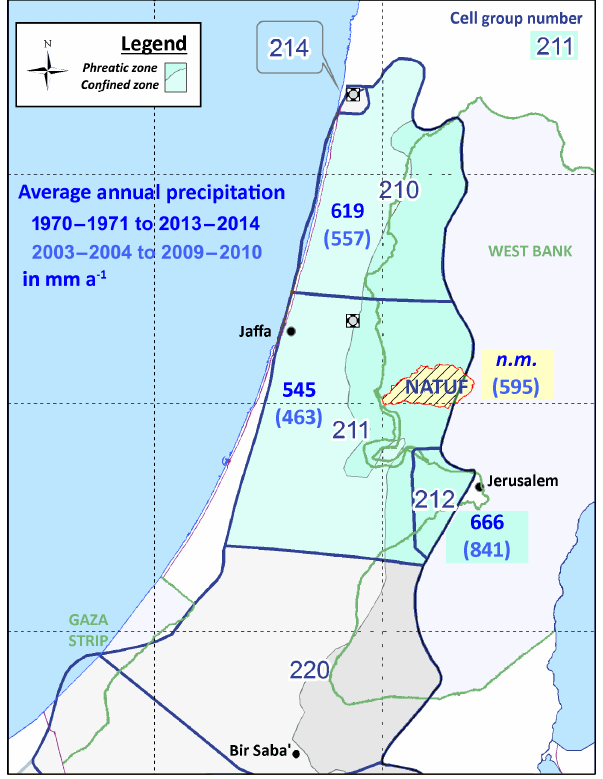
Figure E1. WAB cells of area precipitation (modified after HSI, 2016). The map indicates area precipitation for two periods: long term (1970–1971 to 2013–2014) and the 7 years of this study. Long- term area rainfall data for Wadi Natuf are not available; the 7-year period was measured by tipping buckets. Precipitation data for the three cells groups, nos. 210, 211 and 212, were taken from HSI (2016) (n.m. represents areas which were not